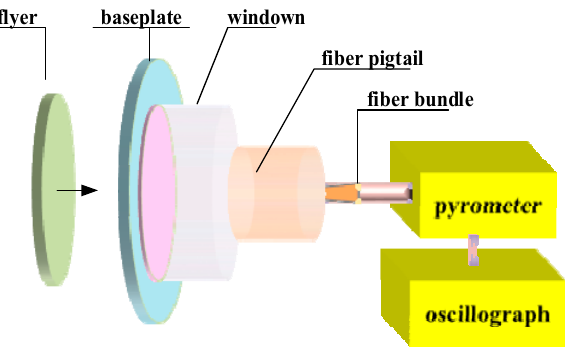
Figure 1. Schematic of light emission measurement system.